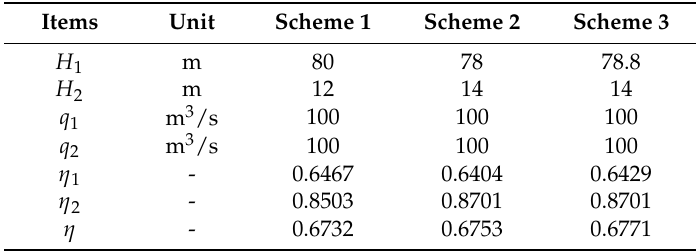
Table 5. Comparison of different operation schemes η = N /(9.81 qH